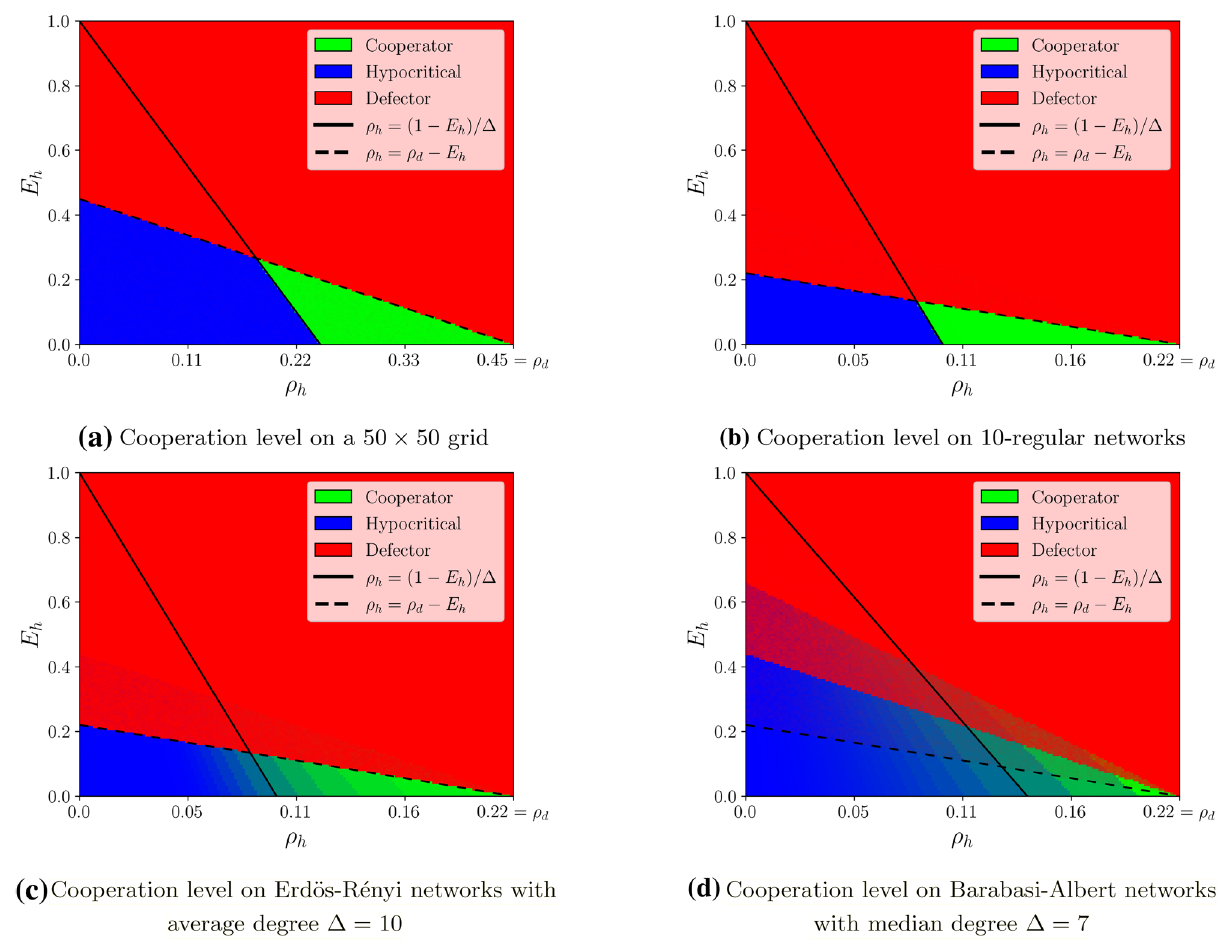
Figure 3. Emergence of cooperation on various networks. The figure depicts the steady-state levels of cooperation on different network families. ( a ) Corresponds to a 50 × 50 grid network, ( b ) corresponds to random 10-regular networks with 1000 vertices, ( c ) corresponds to Erdös–Rényi networks with 1000 vertices and parameter p = 1 / 100 , and ( d ) corresponds to Barabási–Albert networks with 1000 vertices and parameter m = 5 . All simulations start with a configuration in which 99% of players are defectors. In all figures, for each couple (ρ h , E h ) , a pixel is being drawn, whose red (resp. green, blue) component corresponds to the average proportion of defectors (resp. cooperators, hypocrites) at steady state. See “Methods” for more